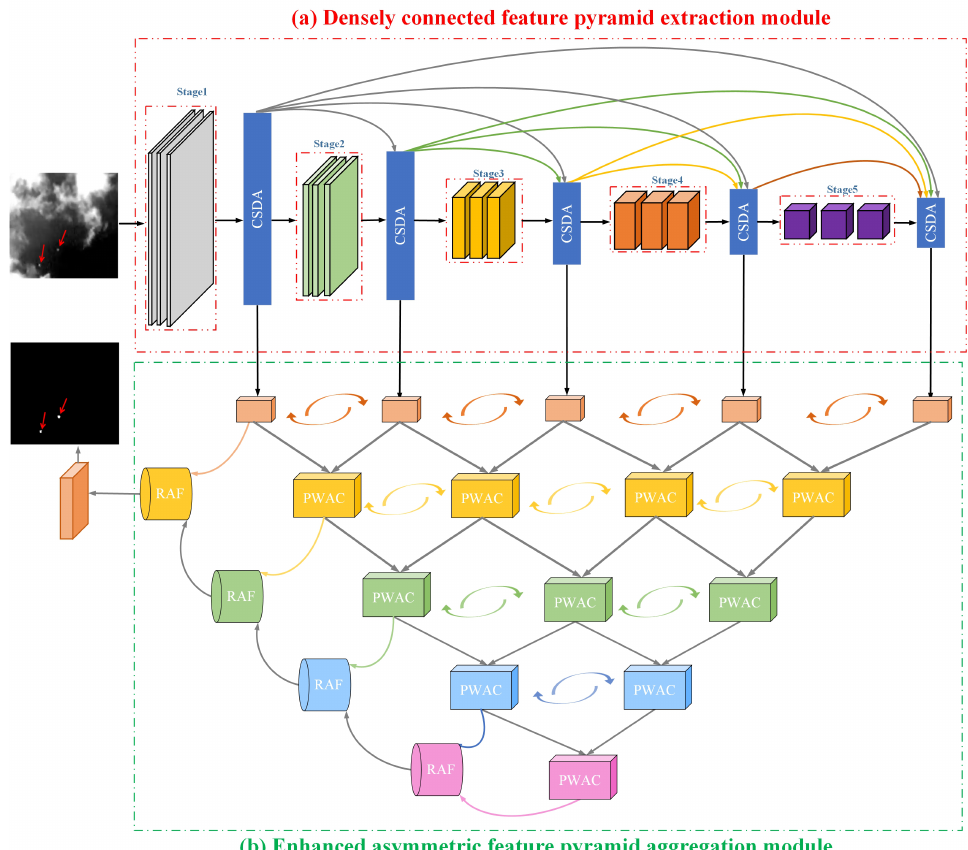
Figure 2. An illustration of the proposed novel asymmetric pyramid aggregation network (APANet). ( a ) Densely connected feature pyramid extraction module. Input images are first fed into the feature pyramid extraction module to extract multi-scale features. Note that, features from different scales are adaptively enhanced by a channel-spatial dual attention (CSDA), and enhanced features from the shallow large-scale space are intensively transferred to the deep small-scale space. ( b ) Enhanced asymmetric feature pyramid aggregation module. The features of adjacent scales are interacted bidirectionally through pair-wise asymmetric combination (PWAC), and these features are aggregated layer-wise in the way of an inverted pyramid. Then, recurrent asymmetric fusion (RAF) is exploited to successively integrate the leftmost multi-level features in the inverted